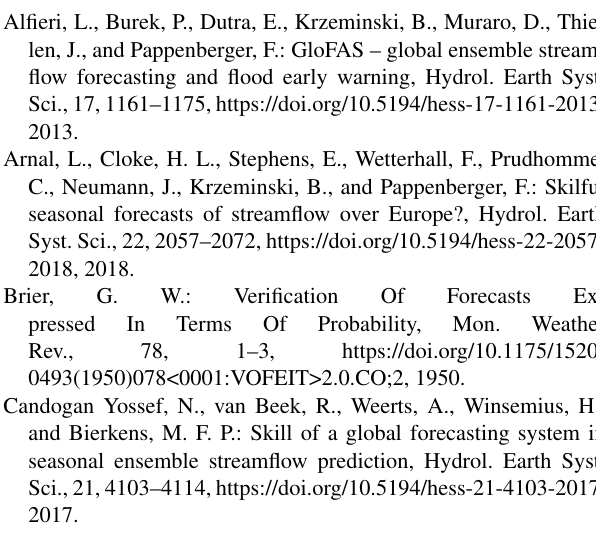
Data availability. Seasonal forecasting and (re)forecasting